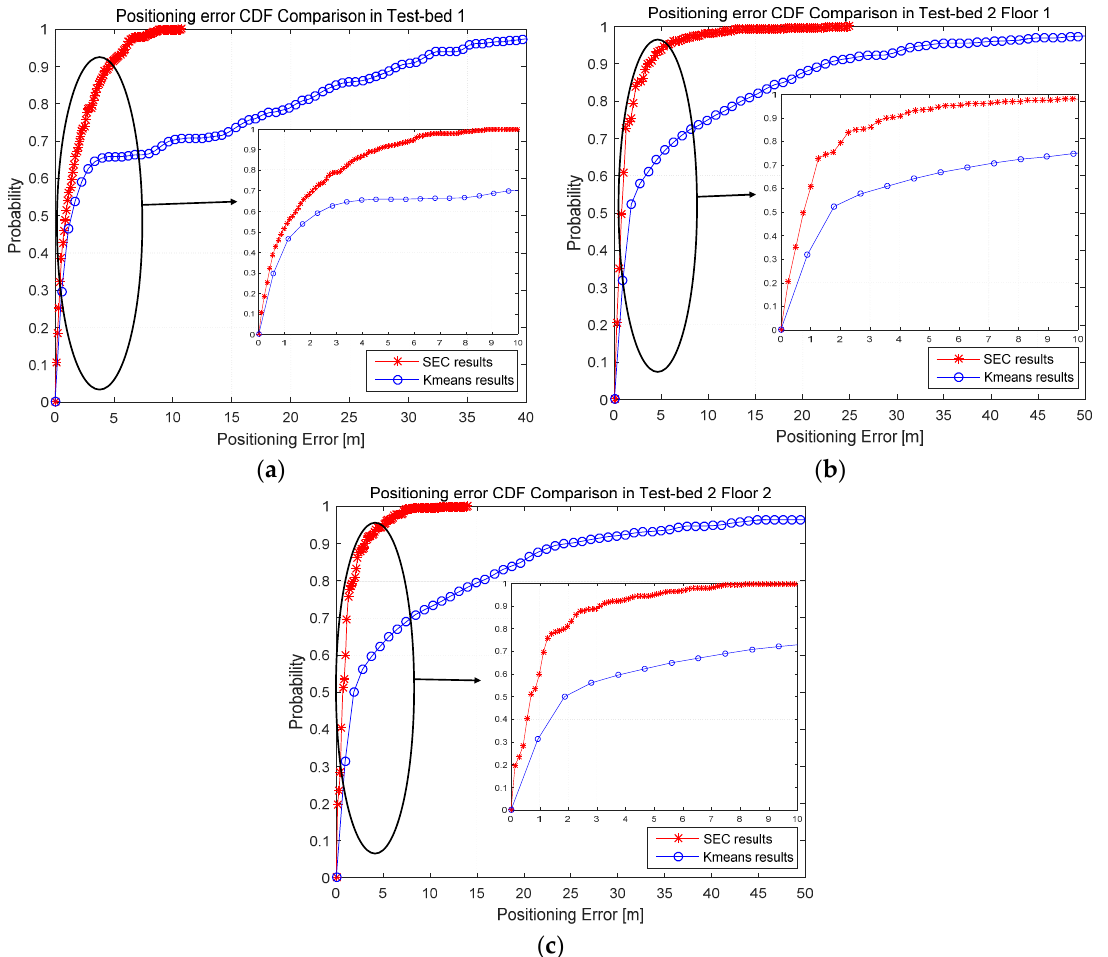
Table 3. Positioning Performance Comparison between K-means and SEC under Modified Weight K Nearest Neighbor (MWKNN) matching.